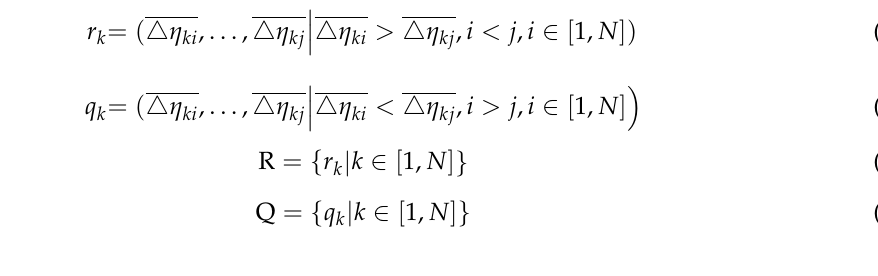
 Figure 4. The second step of aMMTS.